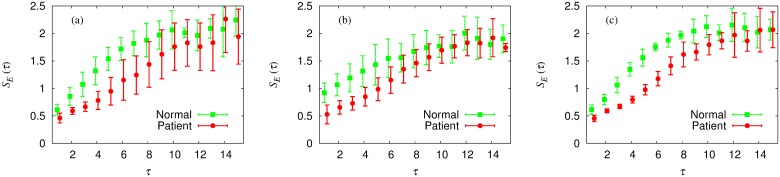
Multiscale entropy S
E of the time series of the rod versus the scale factor τ.(a) X-component, (b) Y-component, and (c) Z-component. Below τ ≈ 10, the multiscale entropy of the normal group (green) is observed to be higher than that of the patient group (red).